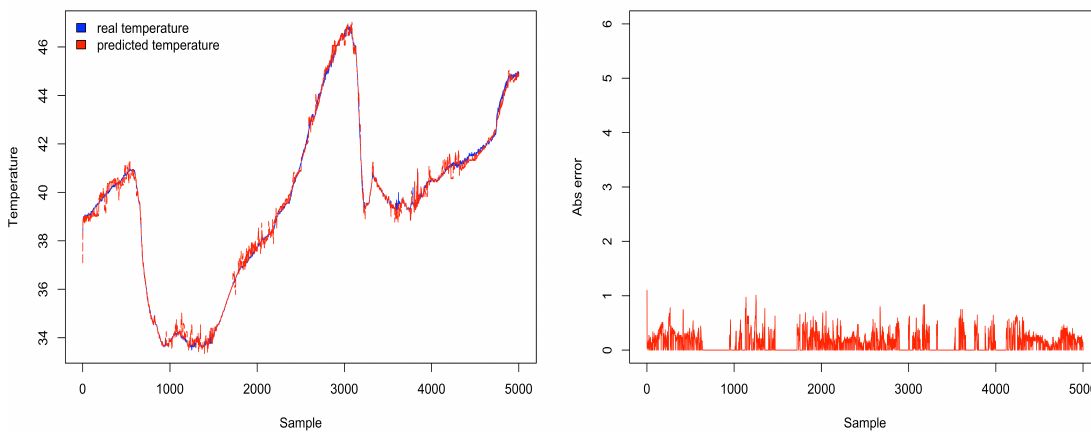
Figure 13. Real and predicted temperatures ( ◦ C) of Node 18 with THRESHOLD equal to